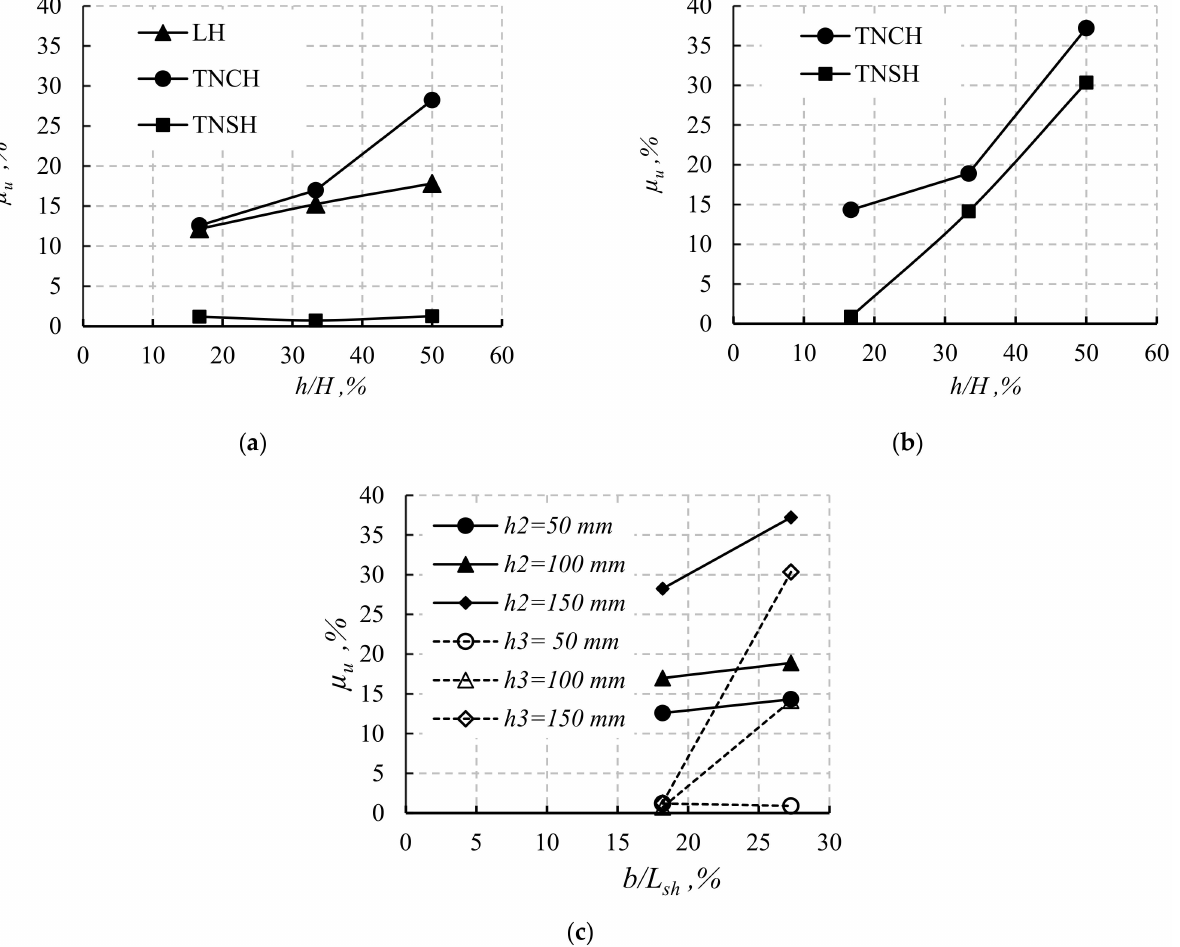
Figure 15. Effect of opening dimensions and position on the reduction in the ultimate load capacity for beams with L = 1100 mm: ( a ) effect of h / H at b = 100 mm; ( b ) effect of h / H at b = 150 mm; ( c ) effect of b / Lsh